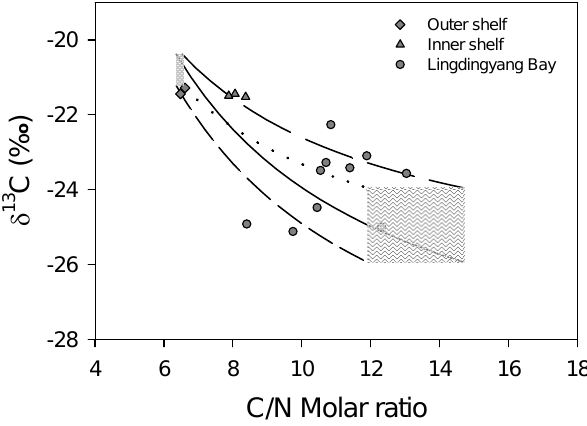
Fig. 6. δ 13 C value of organic carbon versus C/N ratio in the Pearl River Estuary and on the shelf of the South China Sea. The curves represent mixing lines between the terrigenous end-member ( δ 13 C = − 24 . 9 ± 1 . 0‰, C/N=13 . 3 ± 1 . 4, down-right shadow) and ma- rine end-member ( δ 13 C = − 20 . 8 ± 0 . 4‰, C/N=6 . 46 ± 0 . 1, up-left shadow). Given that both end-members of the terrestrial and marine organic carbon had uncentainties, the mixing curves are also shown with ranges (i.e., different curves). Sediments from the upper reach (excluding R01) of the estuary were served as the terrigenous end- member, while net phytoplankton from the northern South China Sea were served as the marine end-member (see text for